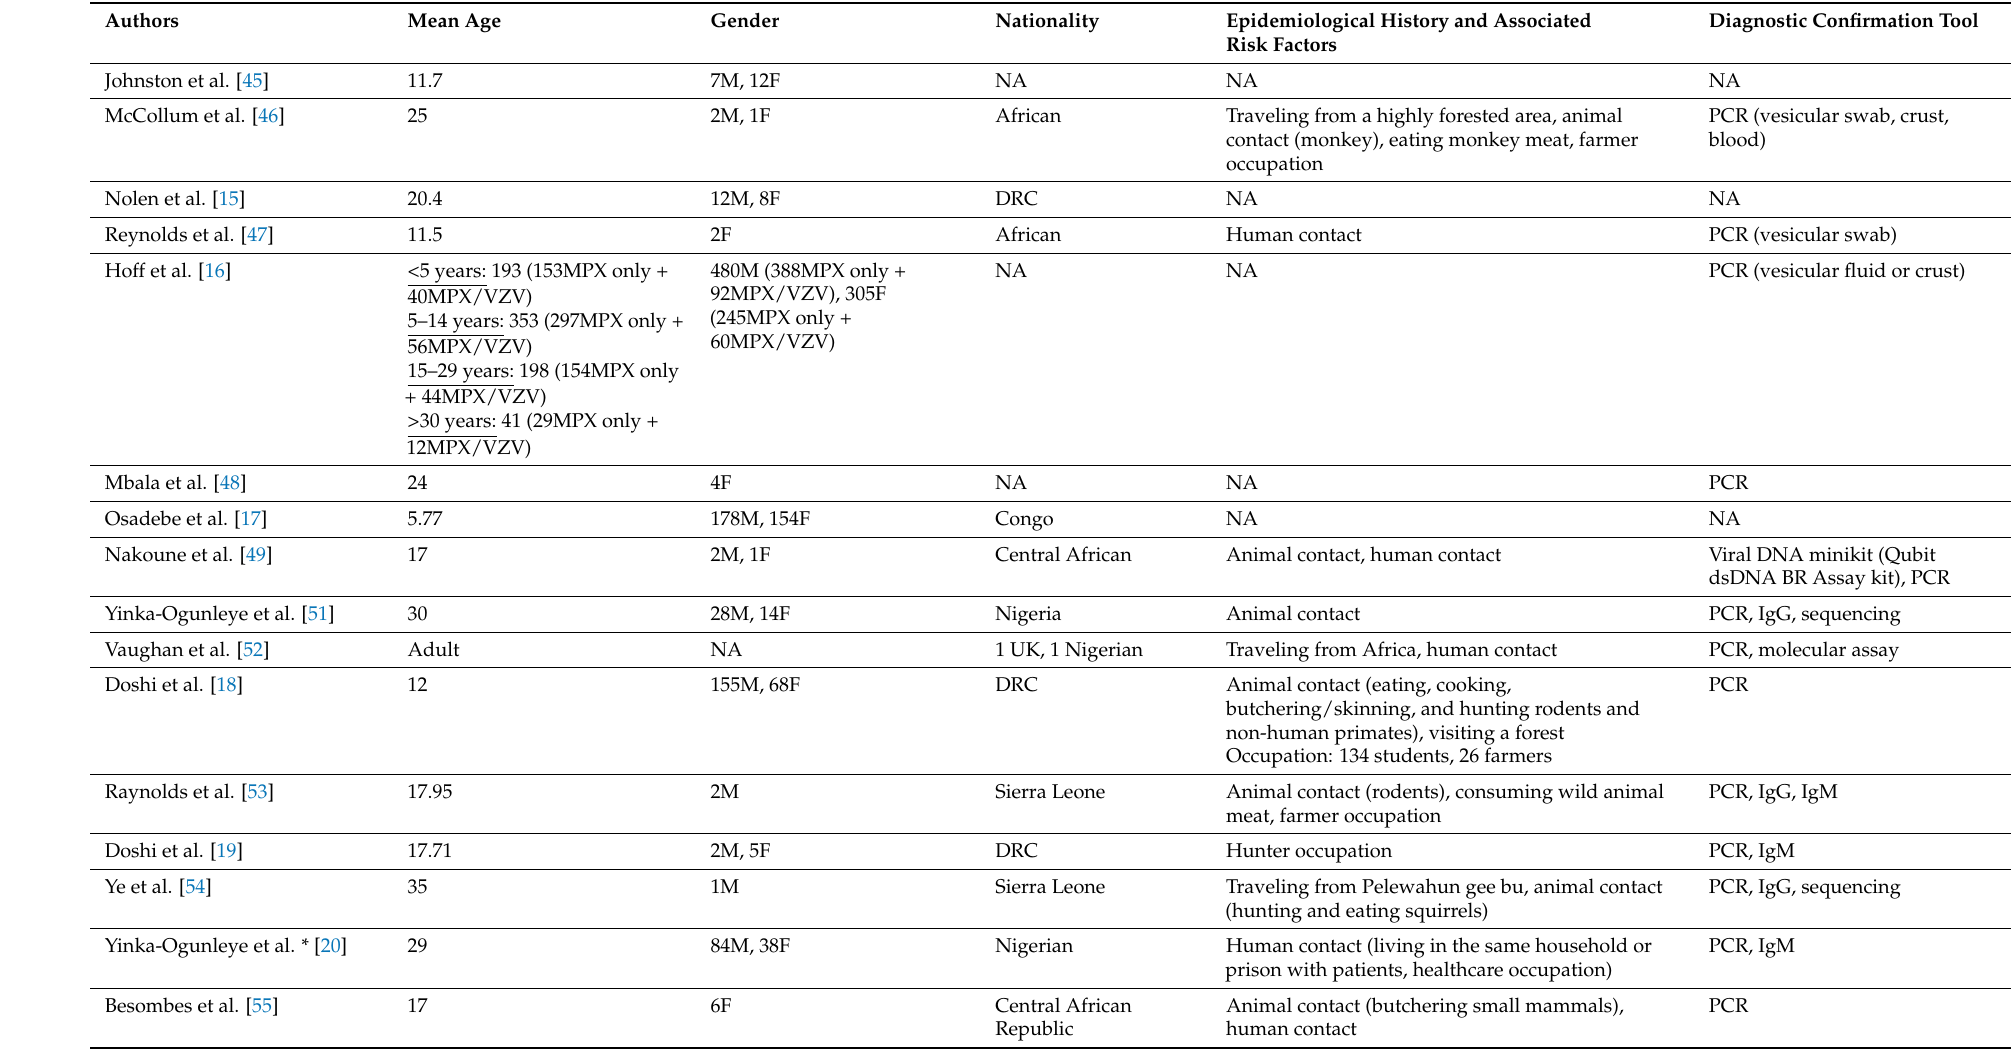
Table 4. Demographic and epidemiologic characteristics of the study population (confirmed